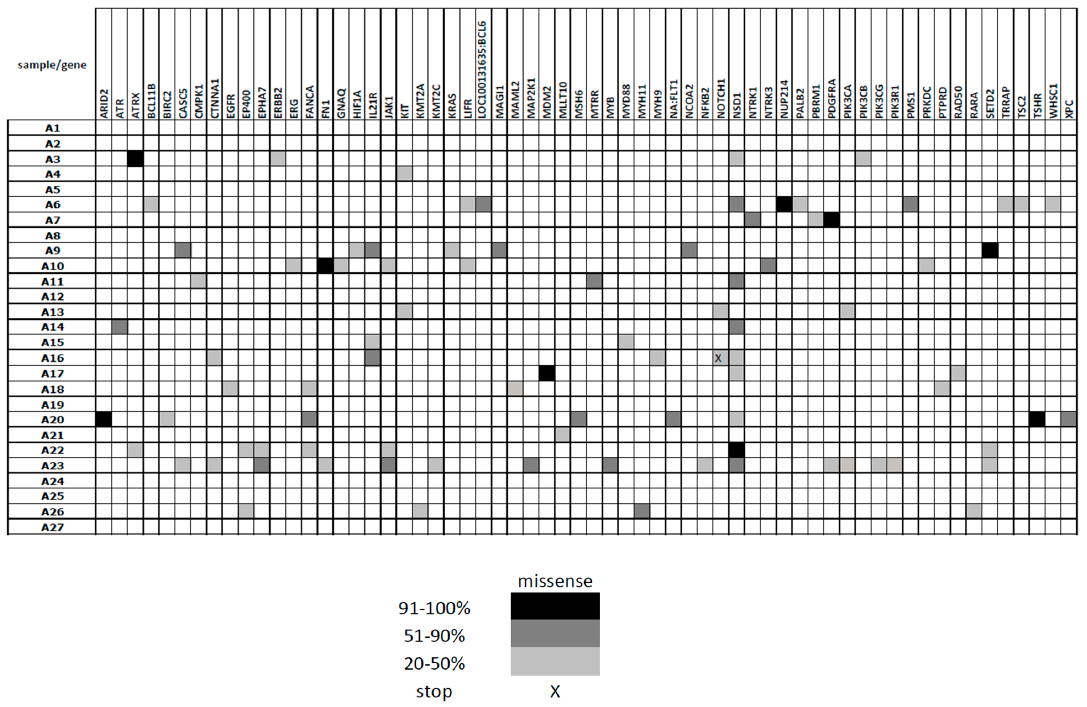
Figure 5. Somatic variants detected by amplicon sequencing in primary TGCT tumors (in comparison to germ-line control patient samples)—variants present in at least 20% of sequencing reads. Table 4. Tumor mutation burden of WES-sequenced patients’ primary TGCT